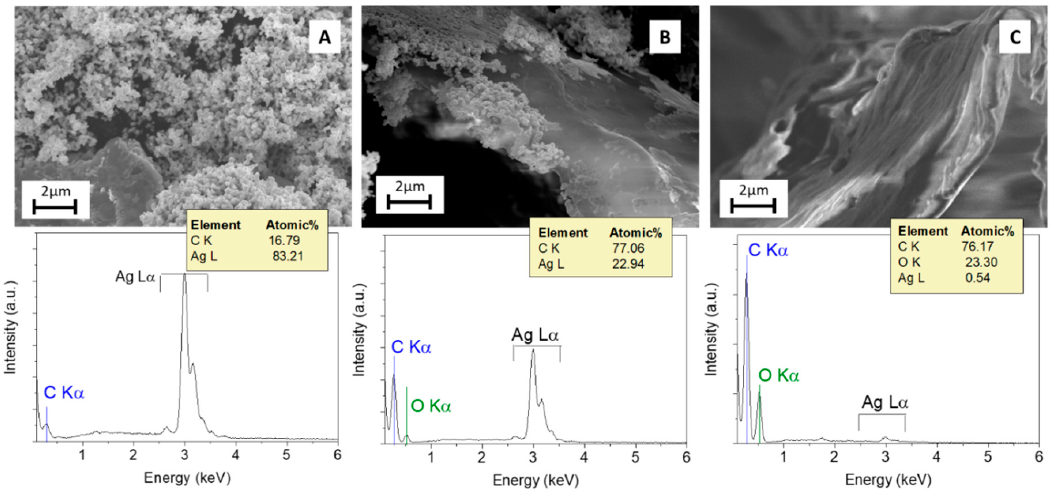
Figure 3. ( A ) Field Emission Scanning Electron Microscopy (FE-SEM) images and the related Energy